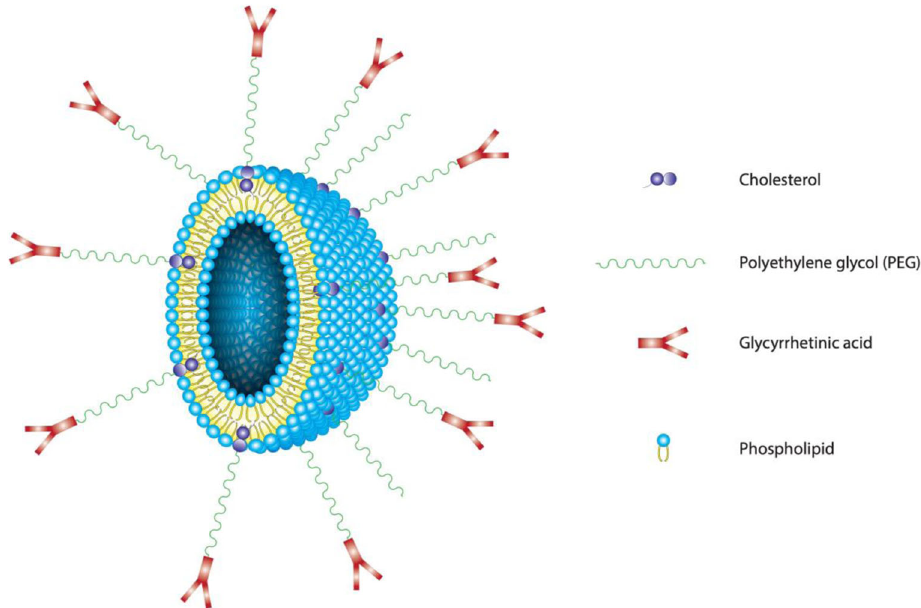
Fig. 1 A multifunctional liposome with hydrophilic shell of PEG and glycyrrhetinic acid